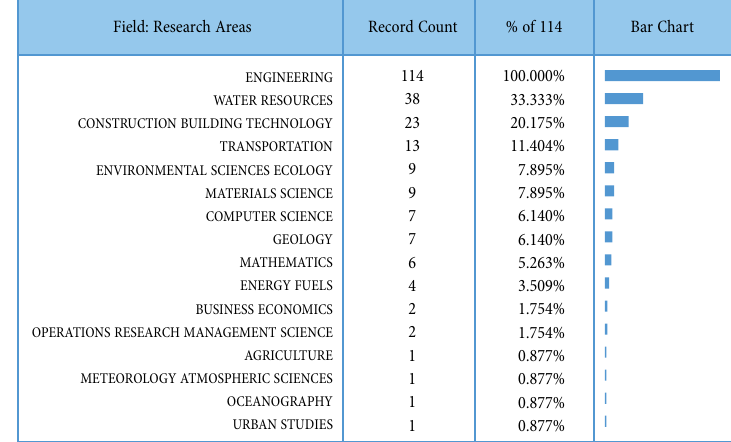
Fig. 1. Records by research